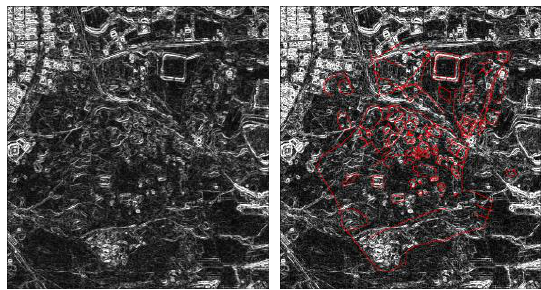
Figure 15 - A Sobel edge detector used on FORMOSAT-2 image of Makhmúr al-Qadíma site with overlaid objects of